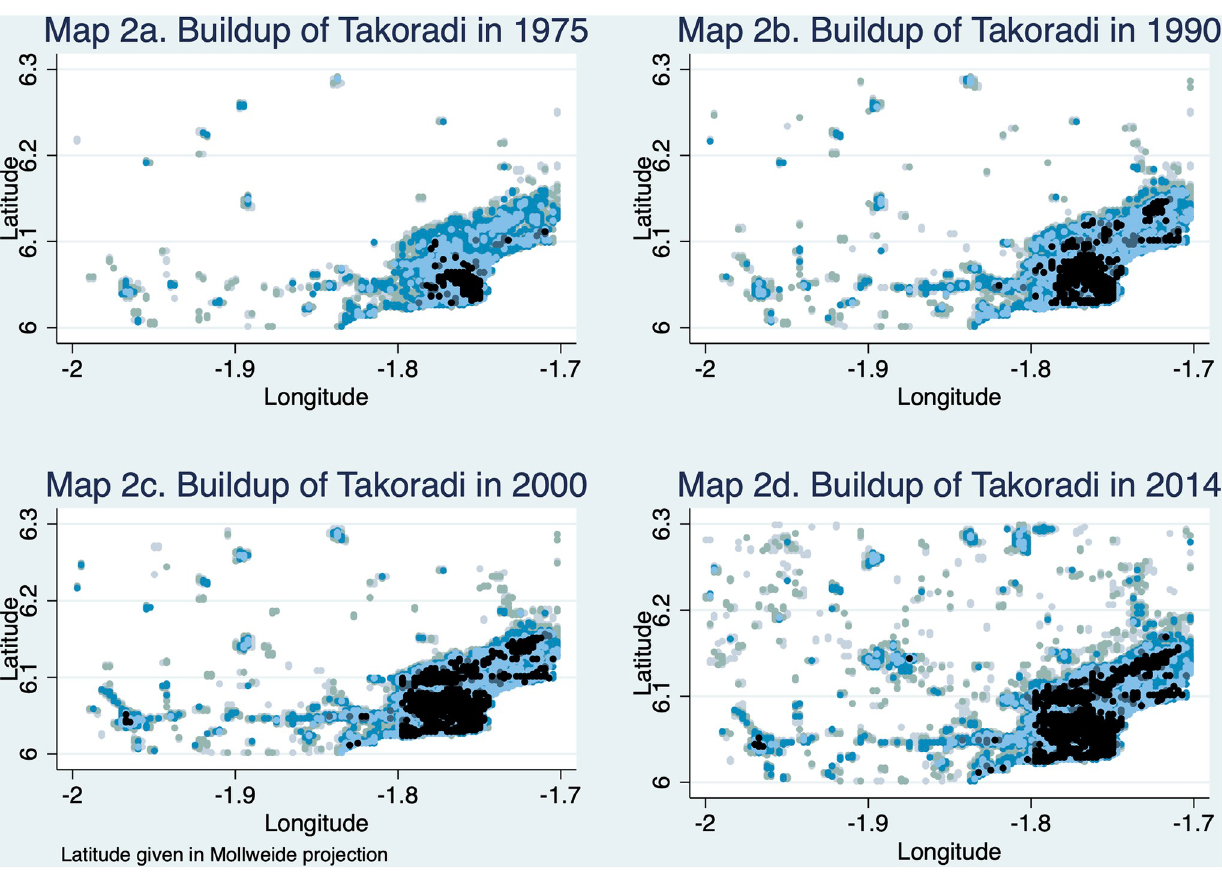
Fig 2. Map 2. Buildup of Takoradi over